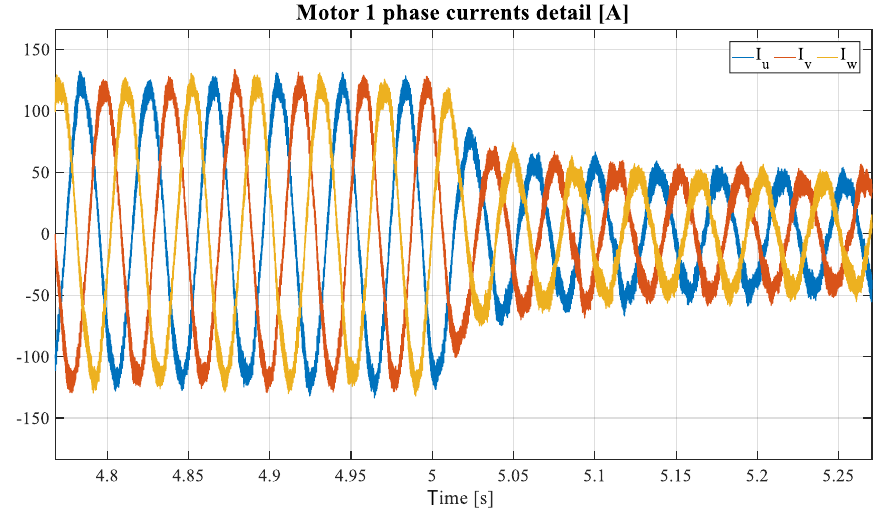
Figure 4. IM phase currents detail at 2400 rpm and 50 Nm load (healthy